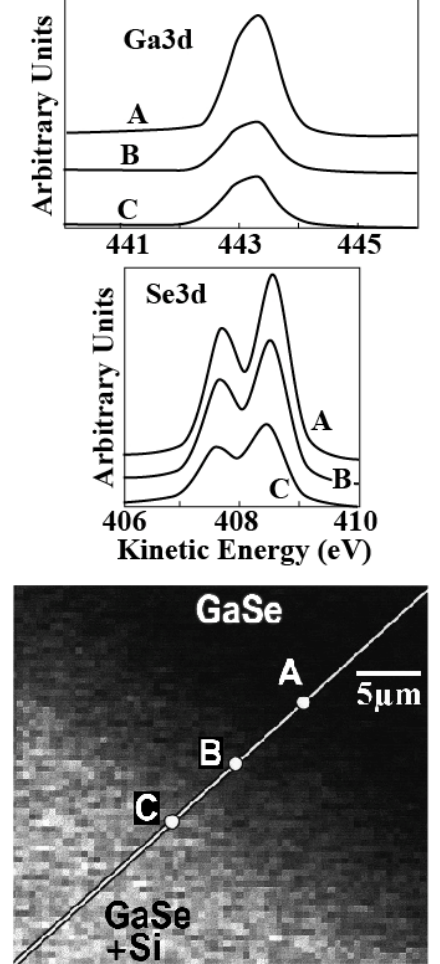
Figure 8. Top and middle: core-level photoemission spectra taken with the approach (a) of Figure 7; the peaks were obtained from a GaSe surface partially covered with Si. Bottom: image of the surface obtained by detecting the Si2p core-level photoemission peak intensity. Points A, B and C mark the positions where the Ga3d and Se3d spectra were taken. Note that the intensity of the Ga and Se peaks is lower in the Si-covered areas. Data from